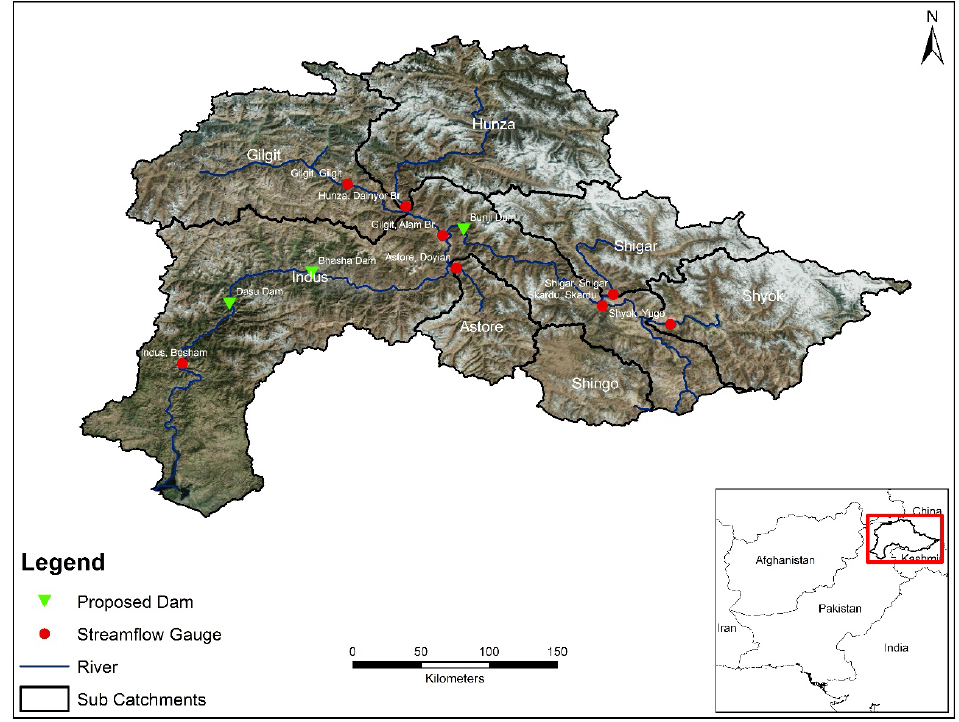
Figure 1. The study area map showing the locations of the stream flow gauges and the proposed dam.